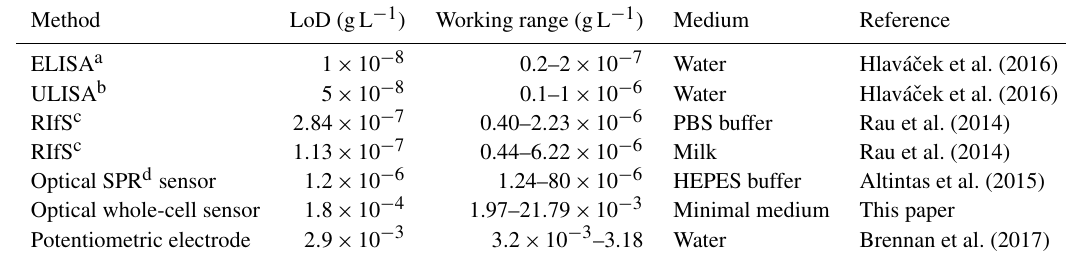
Table 1. Limit of detection (LoD) and working range for detection of diclofenac in comparison with literature values.